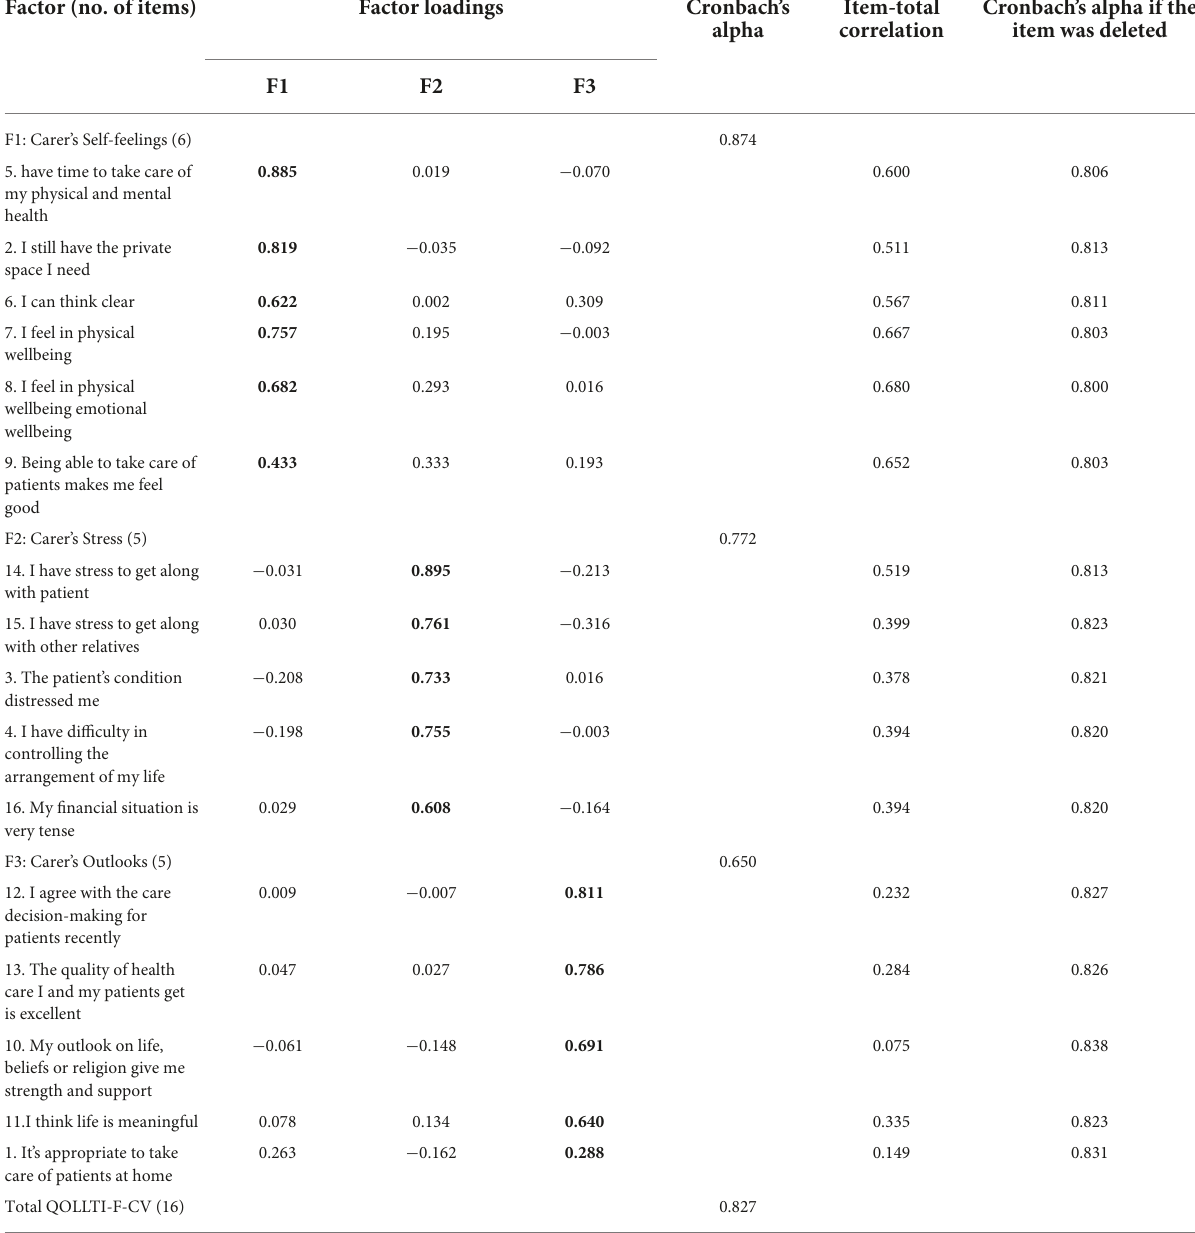
TABLE 2 Exploratory structural equation modeling solution with three factors and Cronbach’s alpha coefficients of the Chinese version of the quality of life in life-threatening illness-family carer version (QOLLTI-F-CV). Factor (no. of